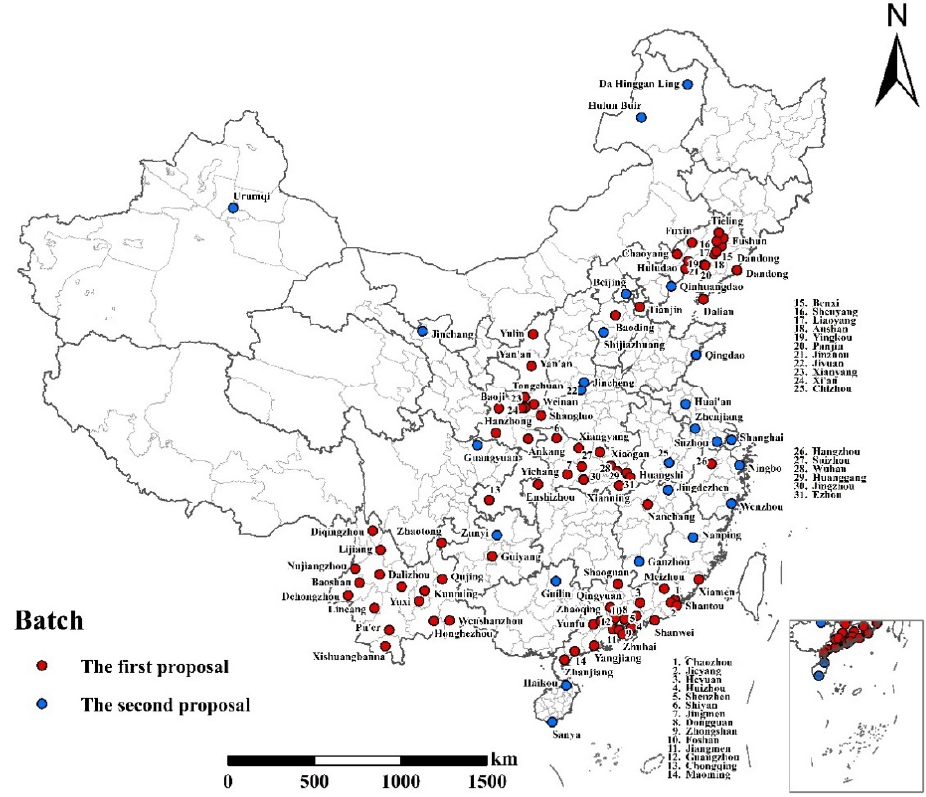
Figure 1. The distribution of the first and second batch of pilot cities.